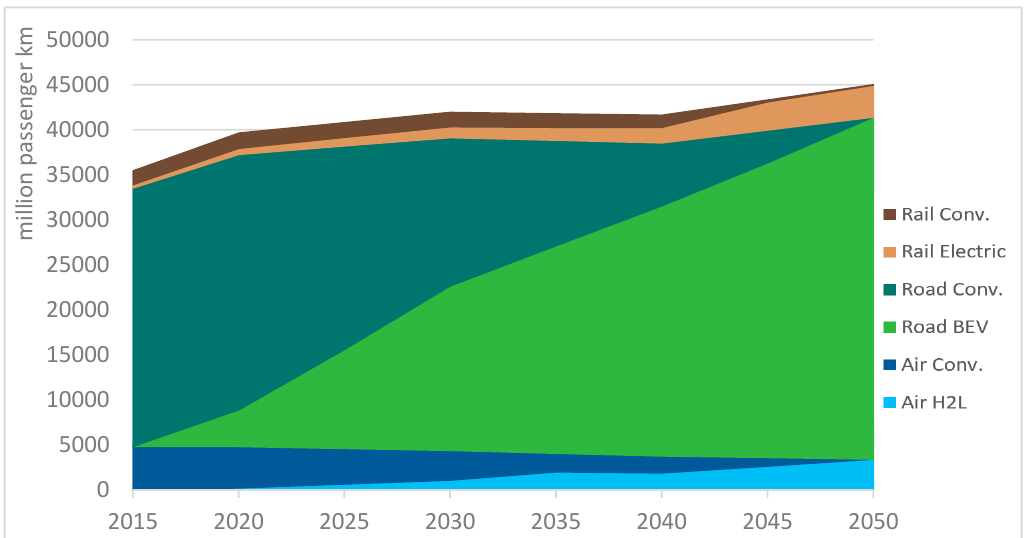
Figure 10. Development of passenger transportation services.